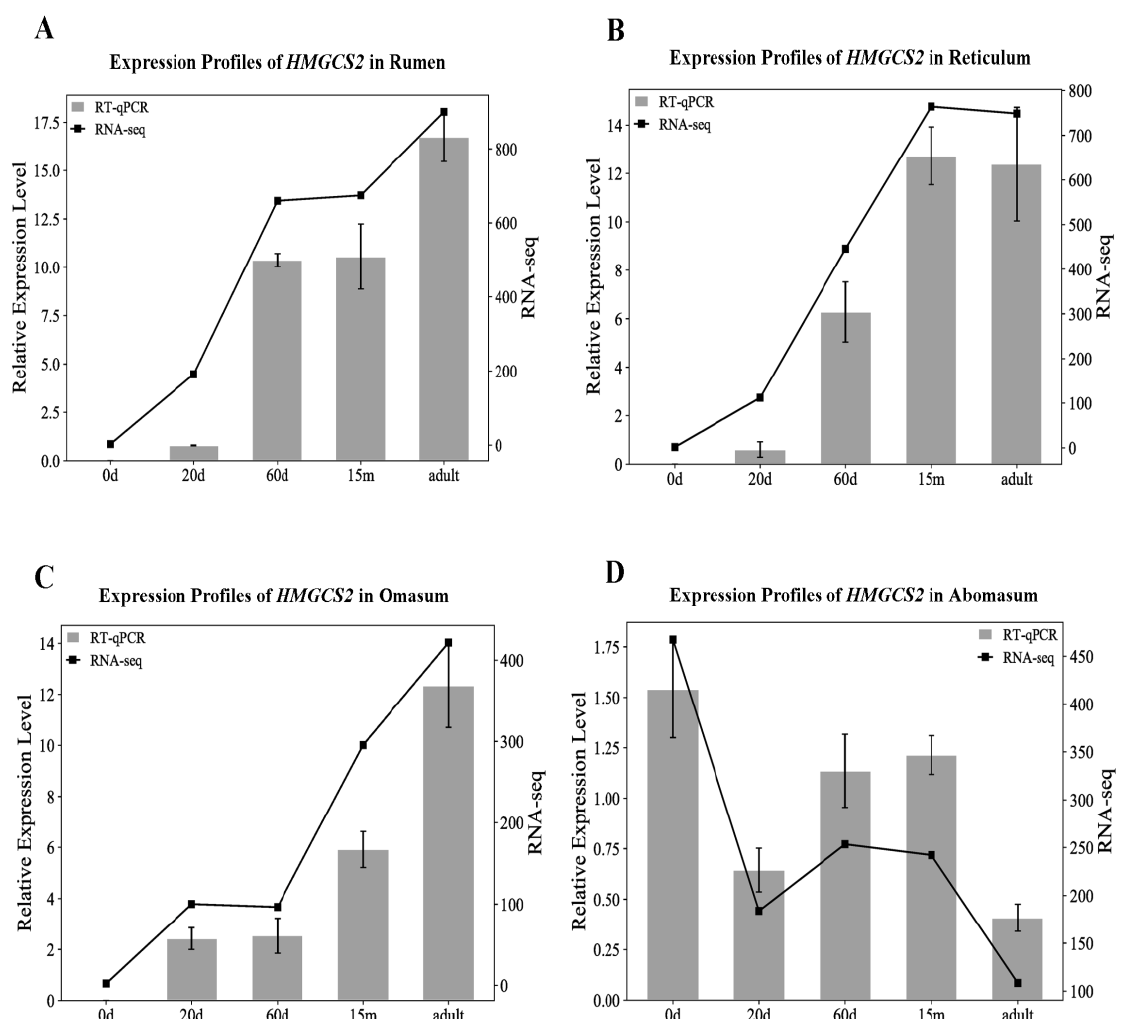
Figure 3. Expression profiles of HMGCS2 in ( A ) rumen, ( B ) reticulum, ( C ) omasum and ( D ) aboma- sum at five developmental stages (0 d, 20 d, 60 d, 15 m and adult). Relative expression level: the RT-qPCR data of HMGCS2 were normalized using RPS15 , MRPL39 and RPS23 . RNA-seq: the arith- metic mean values of FPKM from samples in triplicate at each developmental stage in transcriptome sequencing results.